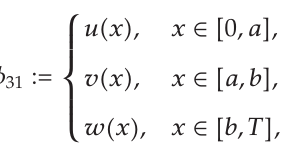
Figure 6: P (cid:2)